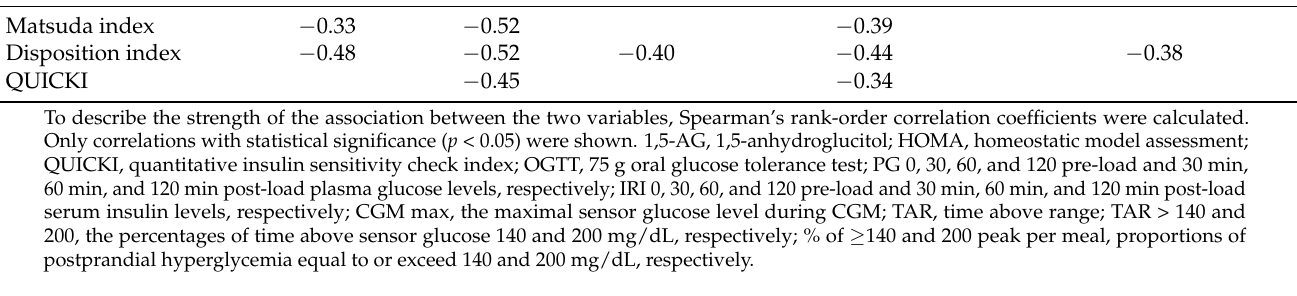
Table 2. Spearman’s rank-order correlation coefficients ( ρ ) of significant associations between lifestyle-related indices and CGM metrics.